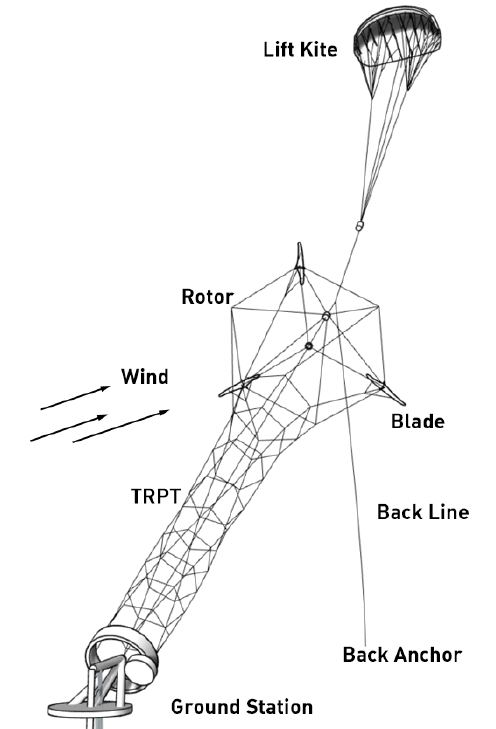
Figure 1. System configuration of the Daisy-Kite AWE